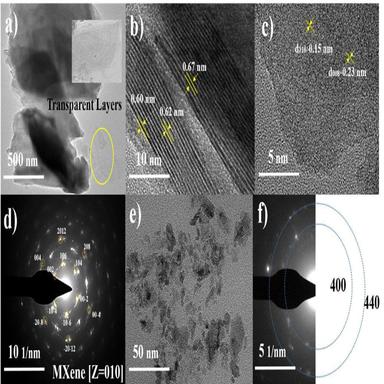
HR-TEM images of (a–c) MXene; (d) SAED pattern of MXene; (e–f) HR-TEM and SAED pattern of MCS.